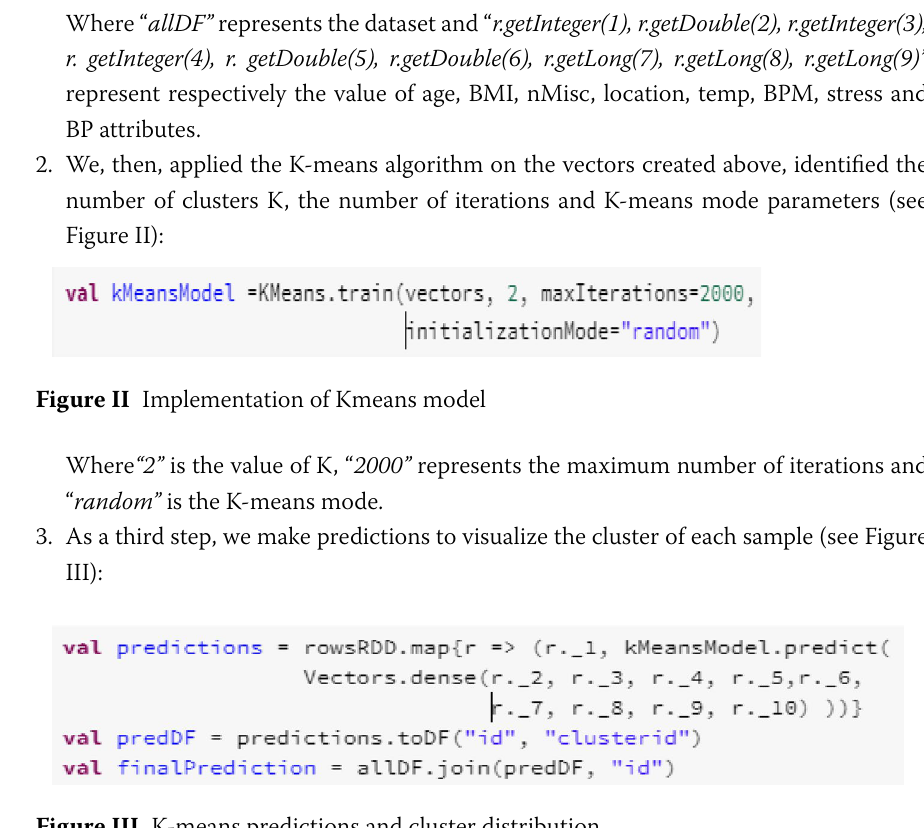
Figure III K-means predictions and cluster distribution Where “ r._2, r._3, r._4, r._5, r._6, r._7, r._8, r._9, r._10” represent respectively attributes of age, BMI, nMisc, location, temp, BPM, stress and BP attributes. While “ clusterid” is the Kmeans